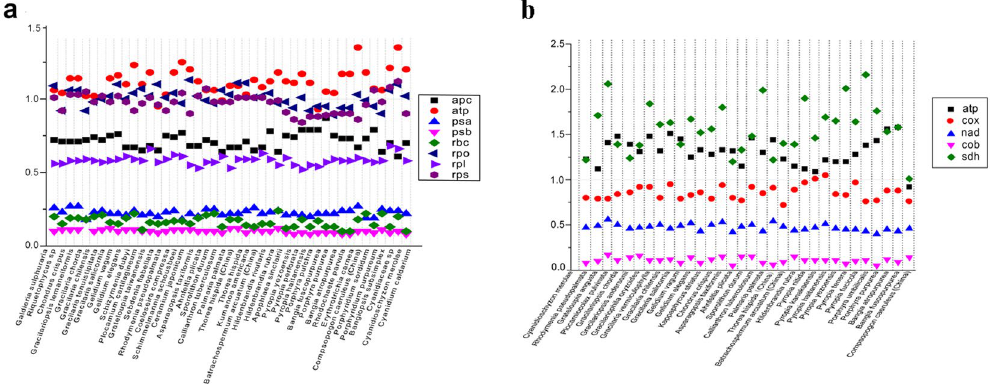
Figure 7. Substitution rates of organelle gene groups. ( a) Substitution rates of chloroplast gene groups. ( b ) Substitution rates of mitochondrial gene